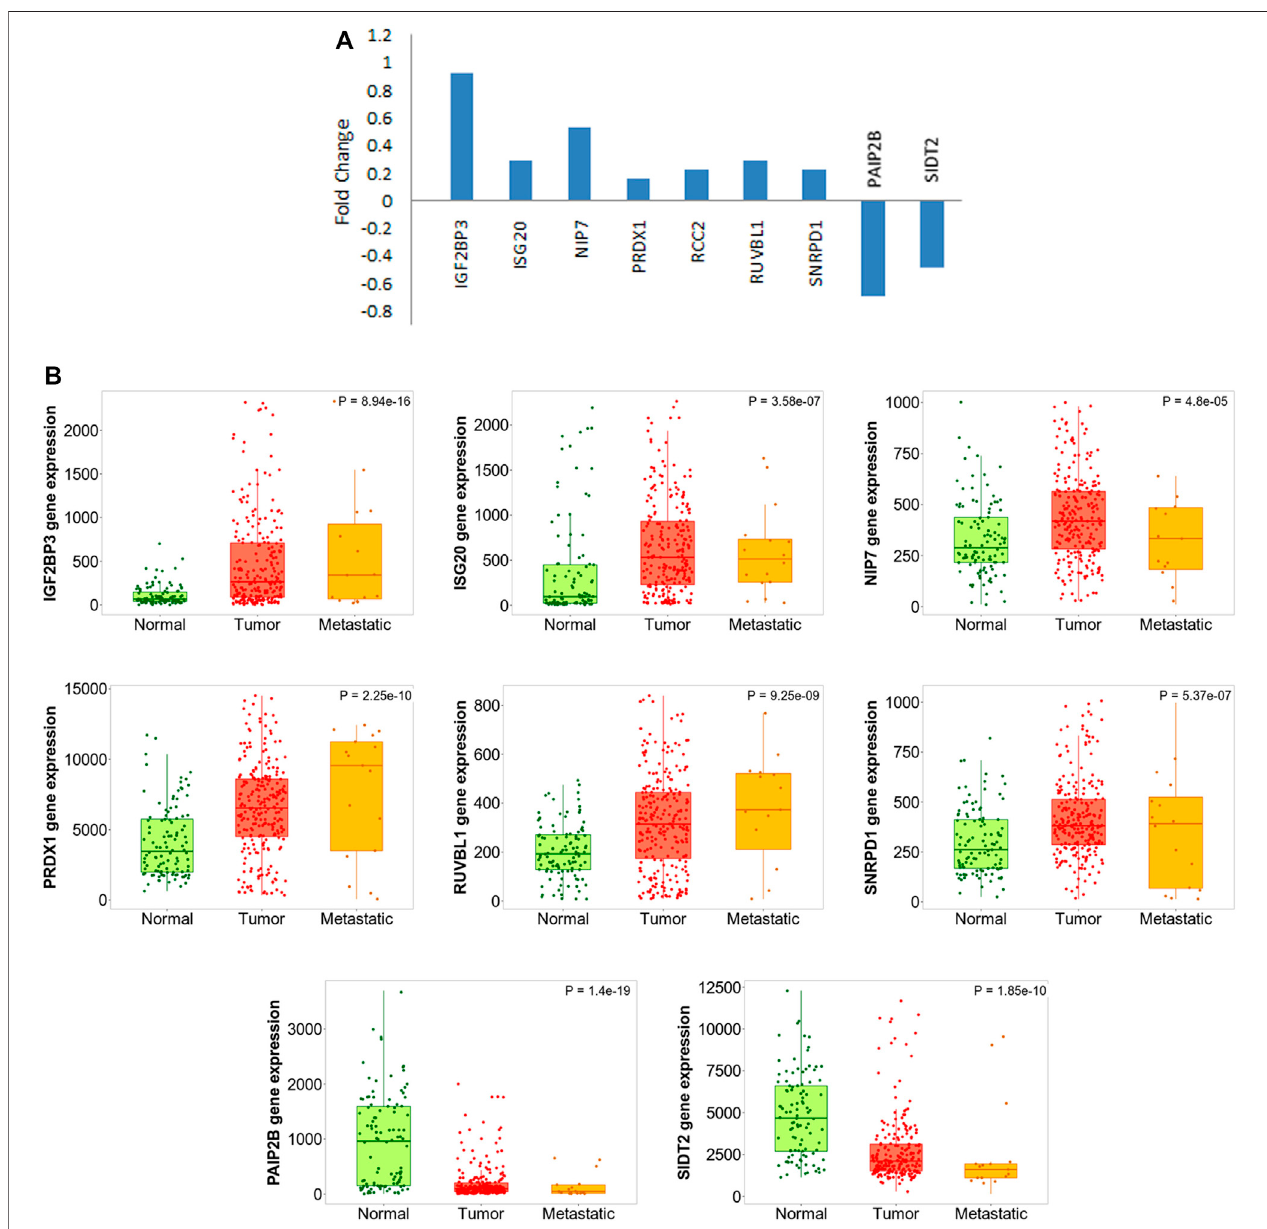
FIGURE 7 | DE-RBP expression deregulated in EMT and metastasis. (A) Barplot shows the expression pattern (log2 fold change) of DE-RBPs to be differentially expressedinTGF- β – inducedEMTinthePanc-1cellline,ascomparedtouninducedPanc-1cells,asobtainedfromthedatabaseGSE23952. (B) Boxplotcomparingthe expression of the abovementioned DE-RBPs in normal, tumor, and metastatic tissue samples as computed using the TNMplot database.